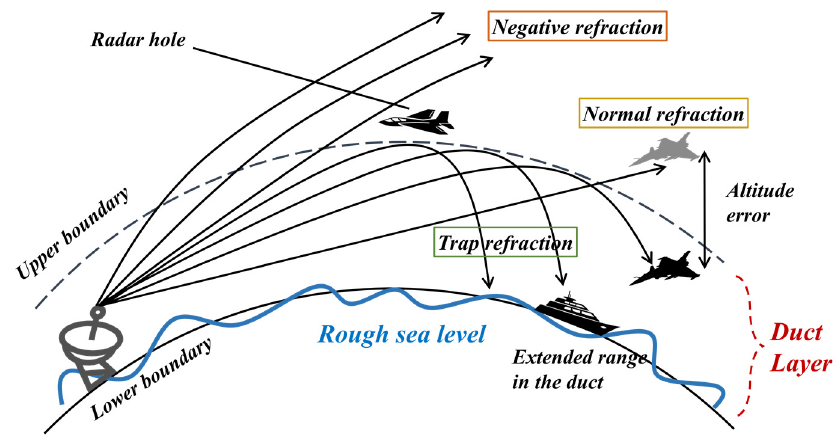
Figure 1. Effects of tropospheric duct on radar performance.